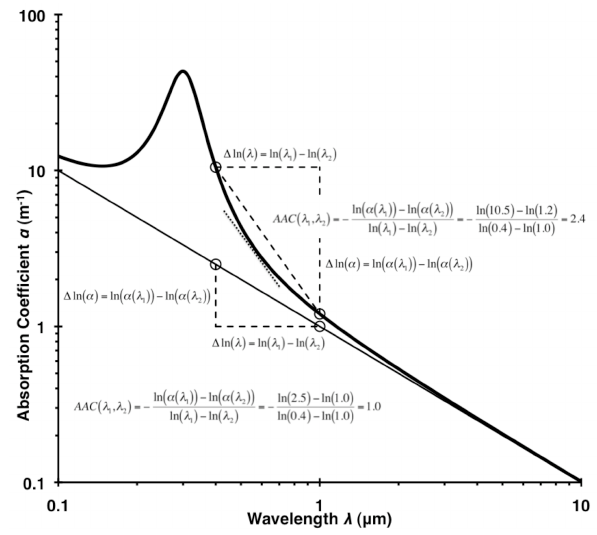
Fig. 1. Illustration of the concept of the absorption ˚Angstr¨om co- efficient being the negative slope of the absorption coefficient as a function of wavelength in a log-log plot. The thin solid line is an ex- ample for BC aerosol in the Rayleigh regime, while the thick solid line is a hypothetical example of what the absorption coefficient of a mixture of BC and BrC may look like, that is the sum of a func- tion with the inverse wavelength dependence of BC and a resonance peak in the